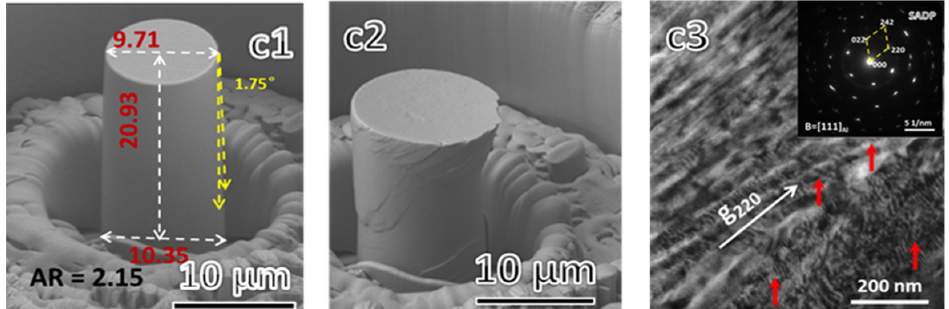
Figure 4. Macro- and micro-structures of micropillars before and after compressive tests from the Al-Al 2 Cu eutectics with different structures of ( a ) as-cast lamellae, ( b ) as-cast degenerate, and ( c ) laser-remelted lamellae; ( a1 – c1 ) the micropillars before compression; ( a2 – c2 ) the micropillars after compression; ( a3 and b3 ) the cross-section views; ( c3 ) the TEM image of the cross-section view. All images except c3 were captured in the SEM with a tilt angle of 52°.